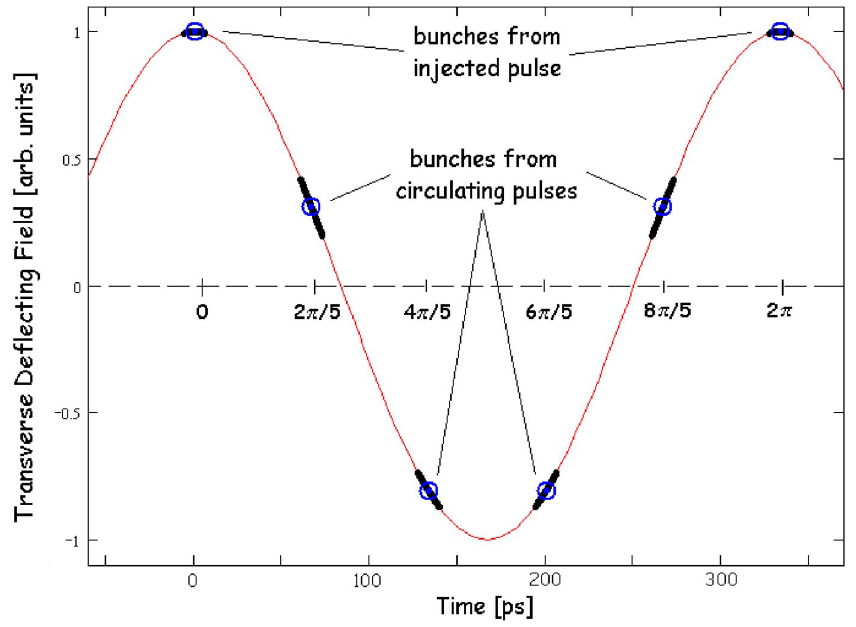
FIG. 4. (Color) Kick amplitude for injected and circulating bunches for a combination factor 5. The longitudinal extension corresponds to (cid:4) 2 (cid:13) for a bunch with a Gaussian distribution with 3 ps rms bunch length. The circles indicate the centers of the bunches.